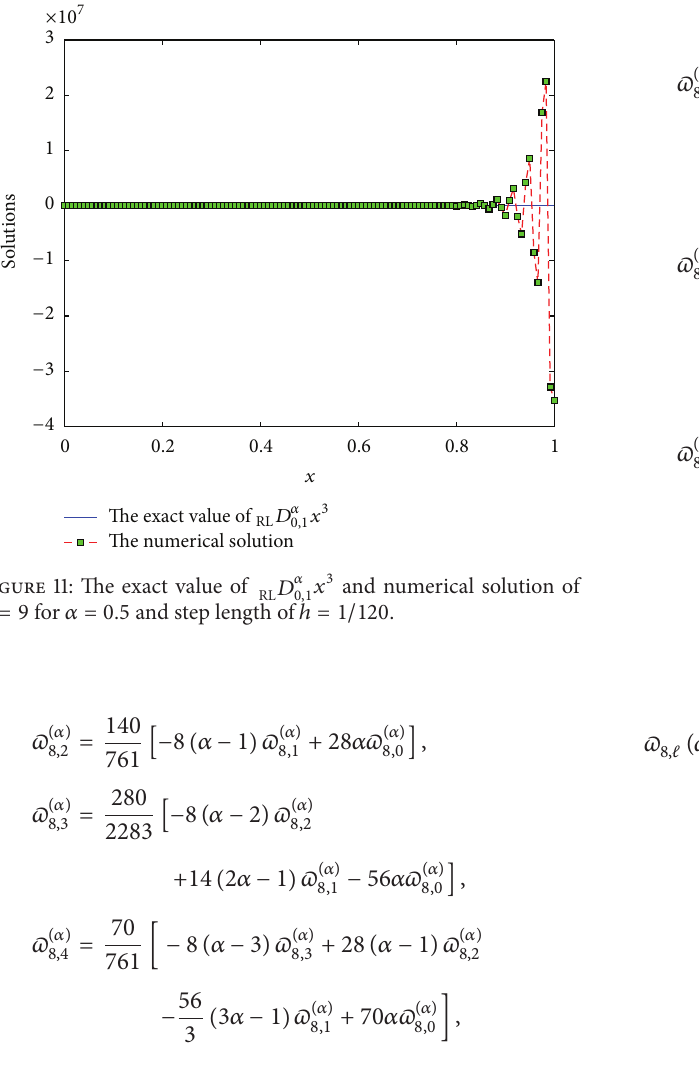
𝑥 3 and numerical solution of 𝐷 𝛼 0,1 RL